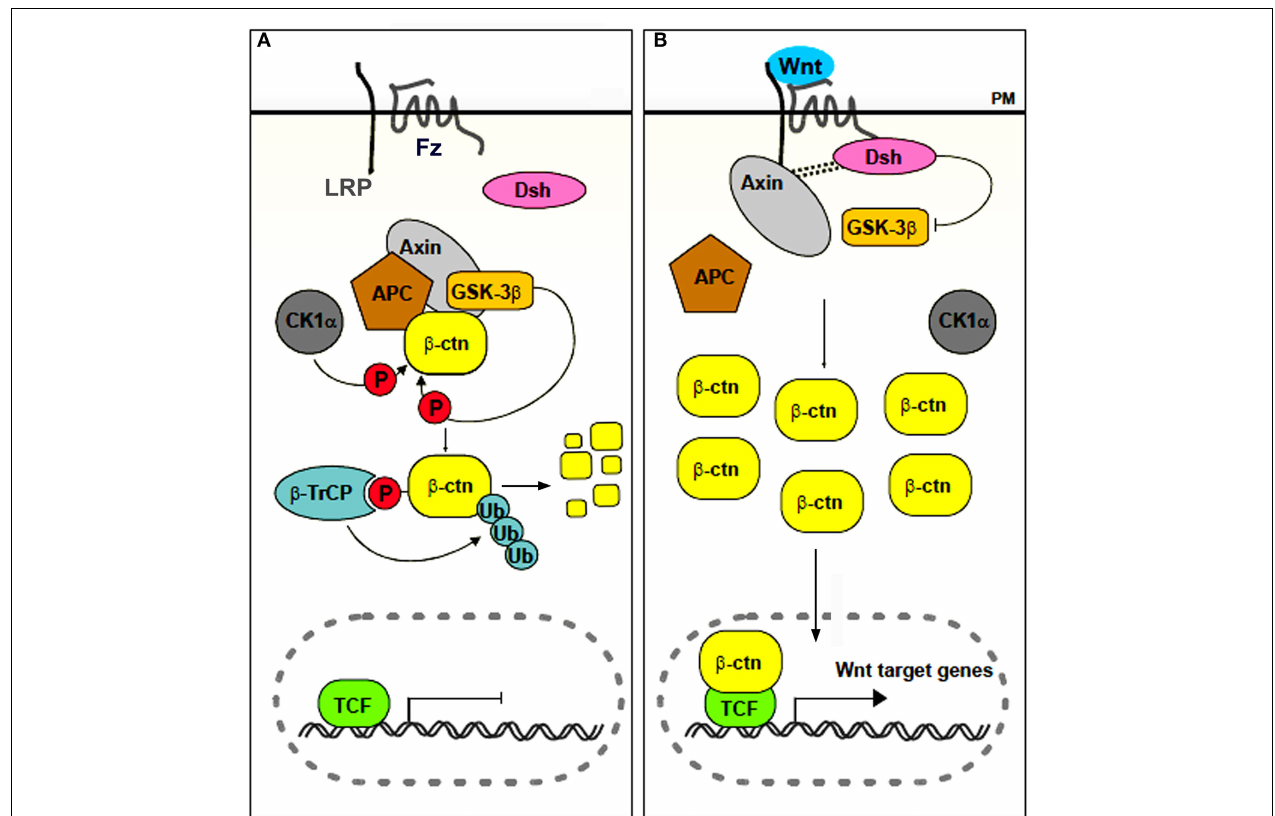
FIGURE 1 | Simplified scheme of canonical Wnt signaling. In the absence of a ligand (A) , or in the presence of an inhibitor, β -catenin accumulates in the cytoplasm and is targeted for destruction. In the presence of a ligand (B) , the destruction complex is disassembled, β -catenin accumulates and translocates to the nucleus, where it associates with transcription factors of the LEF/TCF family to regulate transcription of